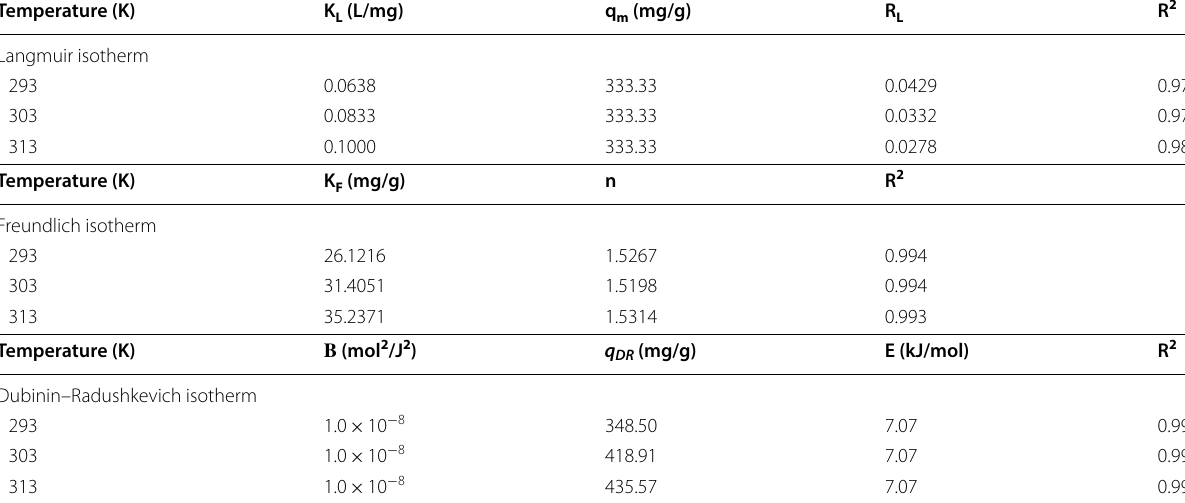
Table 1 Isotherm constants for the adsorption of MG onto TLLP at pH 6.5